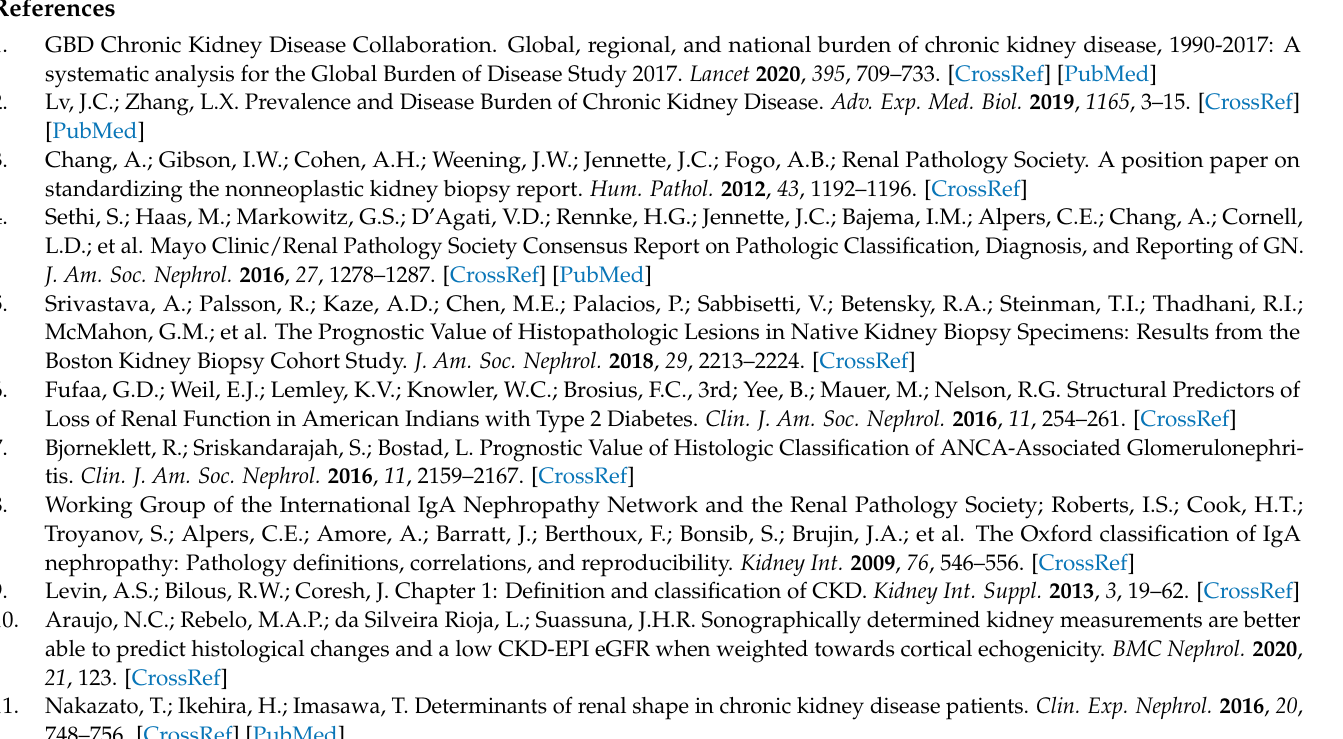
features; Table S2: Summary of morphological features. Table S3: Correlation of morphological features with eGFR according to sex. Table S4: Correlation of morphological features with eGFR according to BMI. Table S5. Correlation of morphological features with eGFR according to